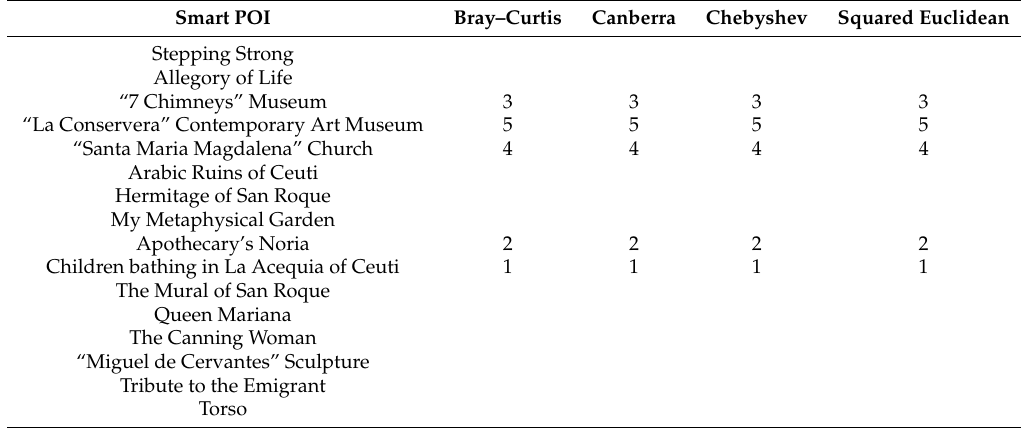
Table 5. Recommendations given by the algorithm to the responder identified by User-CEUTI-1